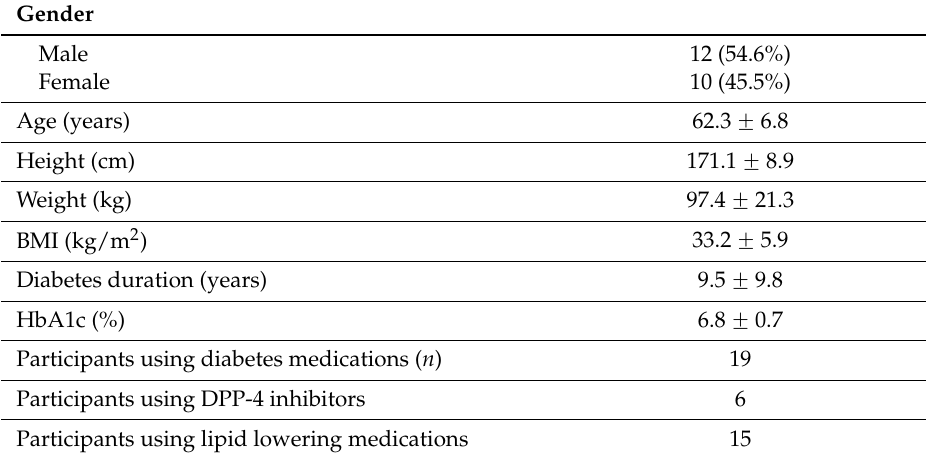
Table 1. Characteristics of study participants ( n =